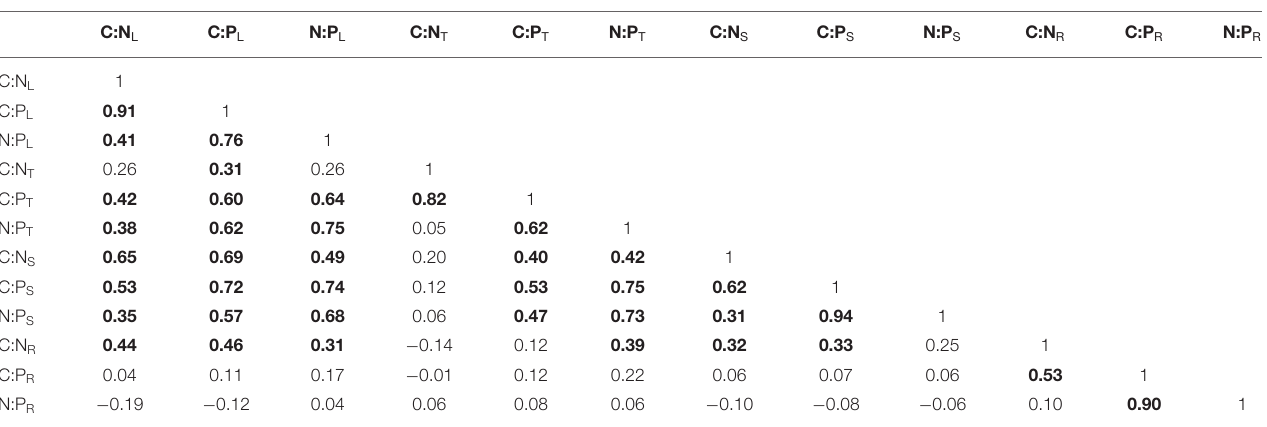
Numbers in bold indicate that the correlation is significant at the 0.05 level (Pearson correlation method, two-tailed).